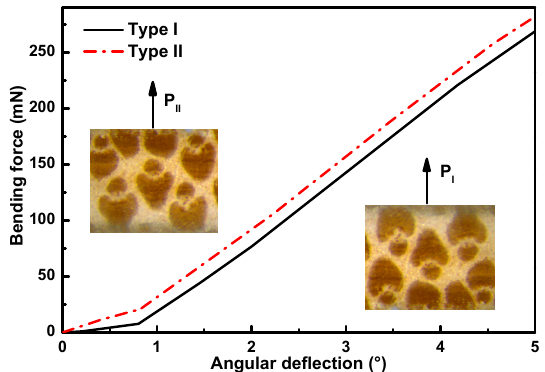
Figure 7. The ( P- α ) curves of B5 layer under loading Type I and II.